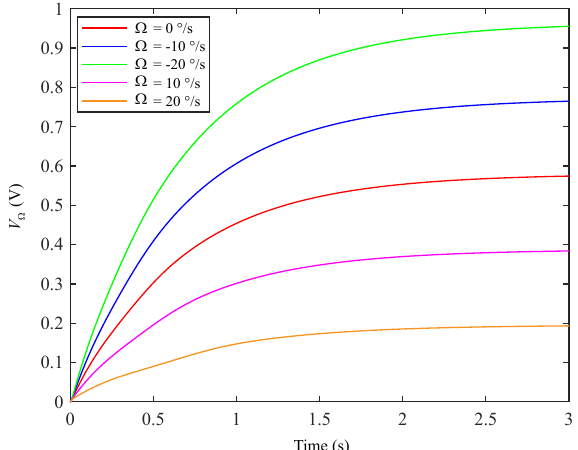
Figure 8. Coriolis signal output curves at different angular